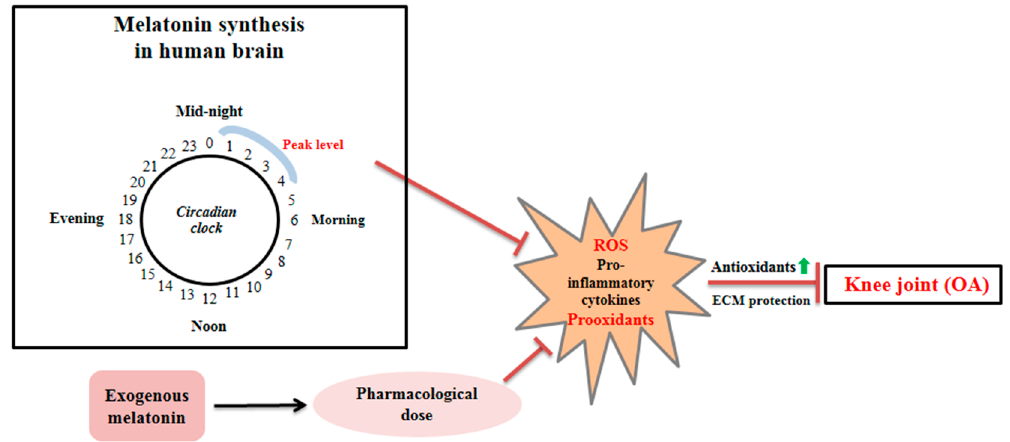
Figure 3. Endogenous melatonin suppresses excessive reactive oxygen species (ROS) production and pro-inflammatory cytokines, and increases antioxidant action during osteoarthritis (OA). In addition, pharmacological treatment with melatonin also shows beneficial effects that protect extracellular matrix (ECM) molecules in articular cartilage.